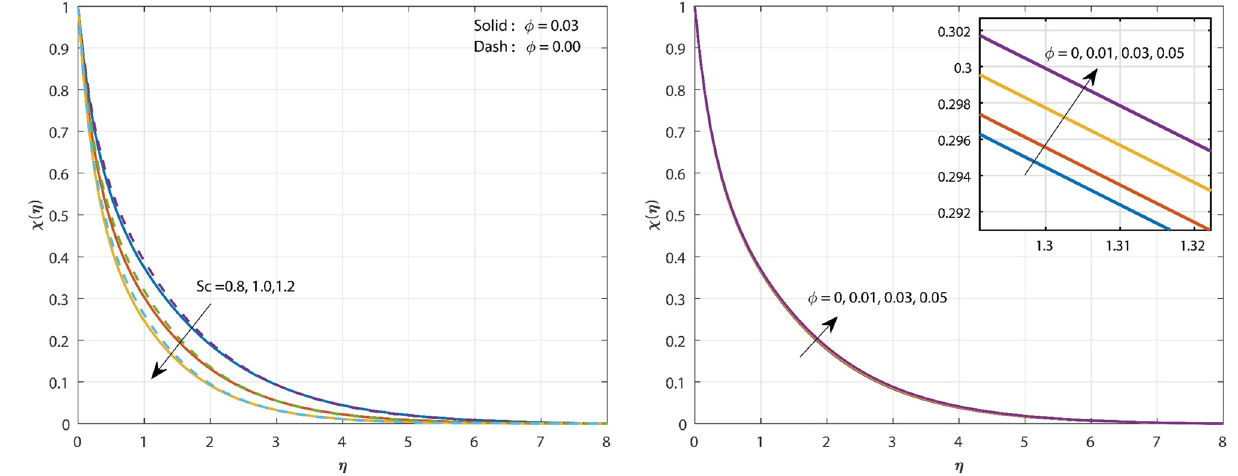
Figure 8: Plot of χ ( η ) over di ff erent values of Sc.